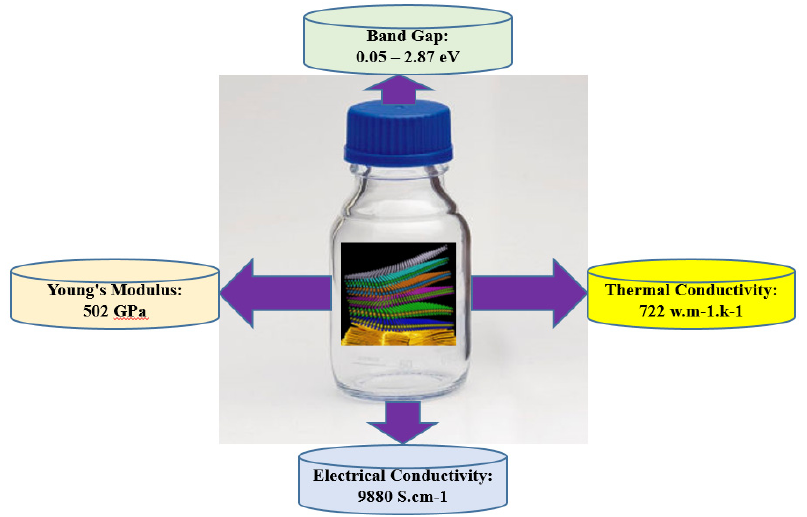
Figure 1. Summary of the mechanical, electronic, thermal, and electrical properties of MXenes. The chemical formula of MXene materials can be written as Mn+1XnTx, where n = 1, 2, or 3, M is the transition metal (Ti, Zr, Hf, V, Nb, Ta, Cr, etc.), X represents carbon C